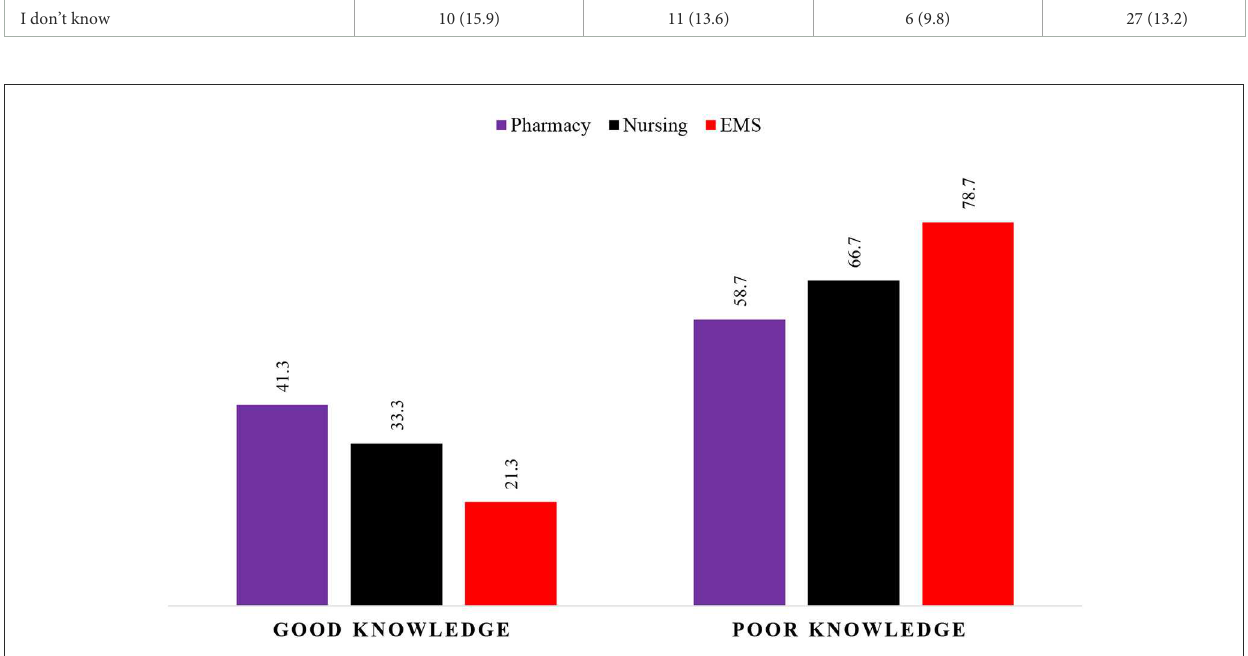
FIGURE1 Level of knowledge according to educational degree.